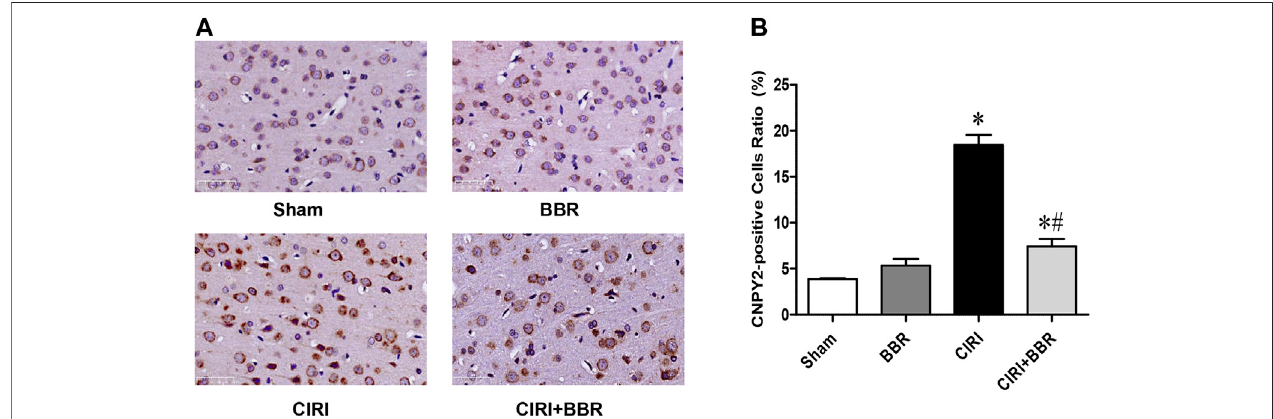
FIGURE 5| BBR inhibits ERS in cortical ischemic penumbra. (A) , Immunohistochemistry results showed that CNPY2-positive neurons were found in the ischemic penumbraarea ofeach model group. (B) , Ratio ofpositivecells. Originalmagni fi cation is400 × , scalebars is20 μ m n (cid:2) 6.Dataare shown asthemean ± SEM. * p < 0.05 compared with Sham group; # p < 0.05 compared with the CIRI group.